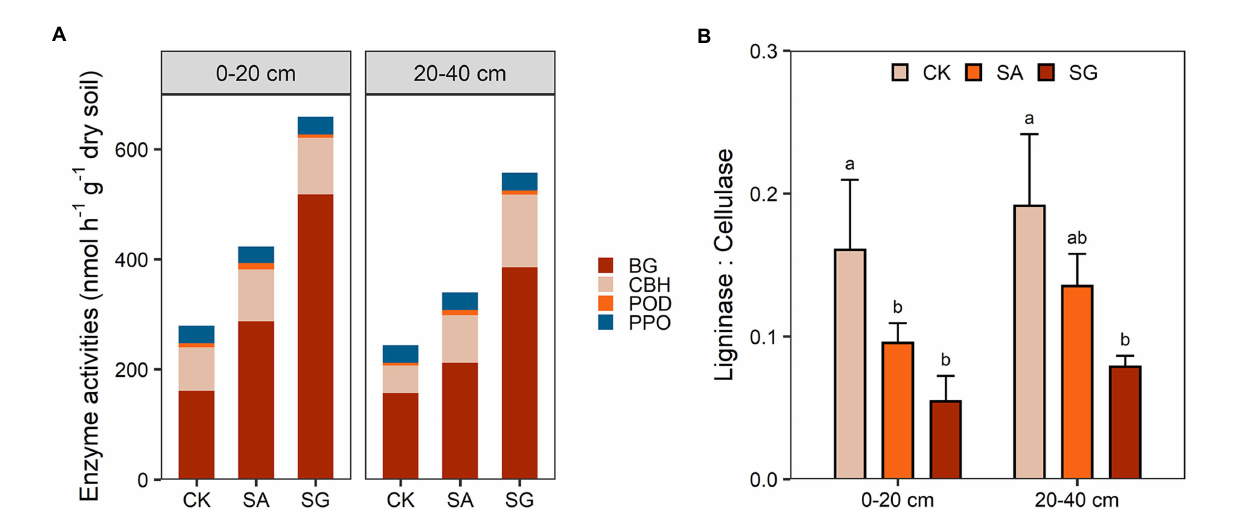
FIGURE 6 Effects of different restoration modes on soil carbon-cycling enzyme activities (A) and the ratio of ligninase to cellulase (B) . CK, extremely degraded grassland. SA, planting shrub with Salix cupularis alone (SA). SG, planting shrub with Salix cupularis plus mixed grasses. Error bars indicate standard deviation; different lowercase letters indicate significant differences at p < 0.05 among treatments, based on the Tukey’s honest significance difference (HSD) test.